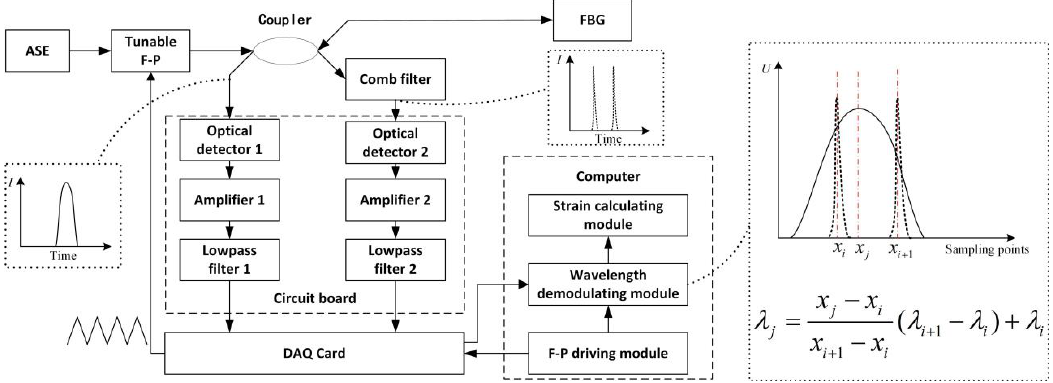
Figure 10. Principle of the measurement system.